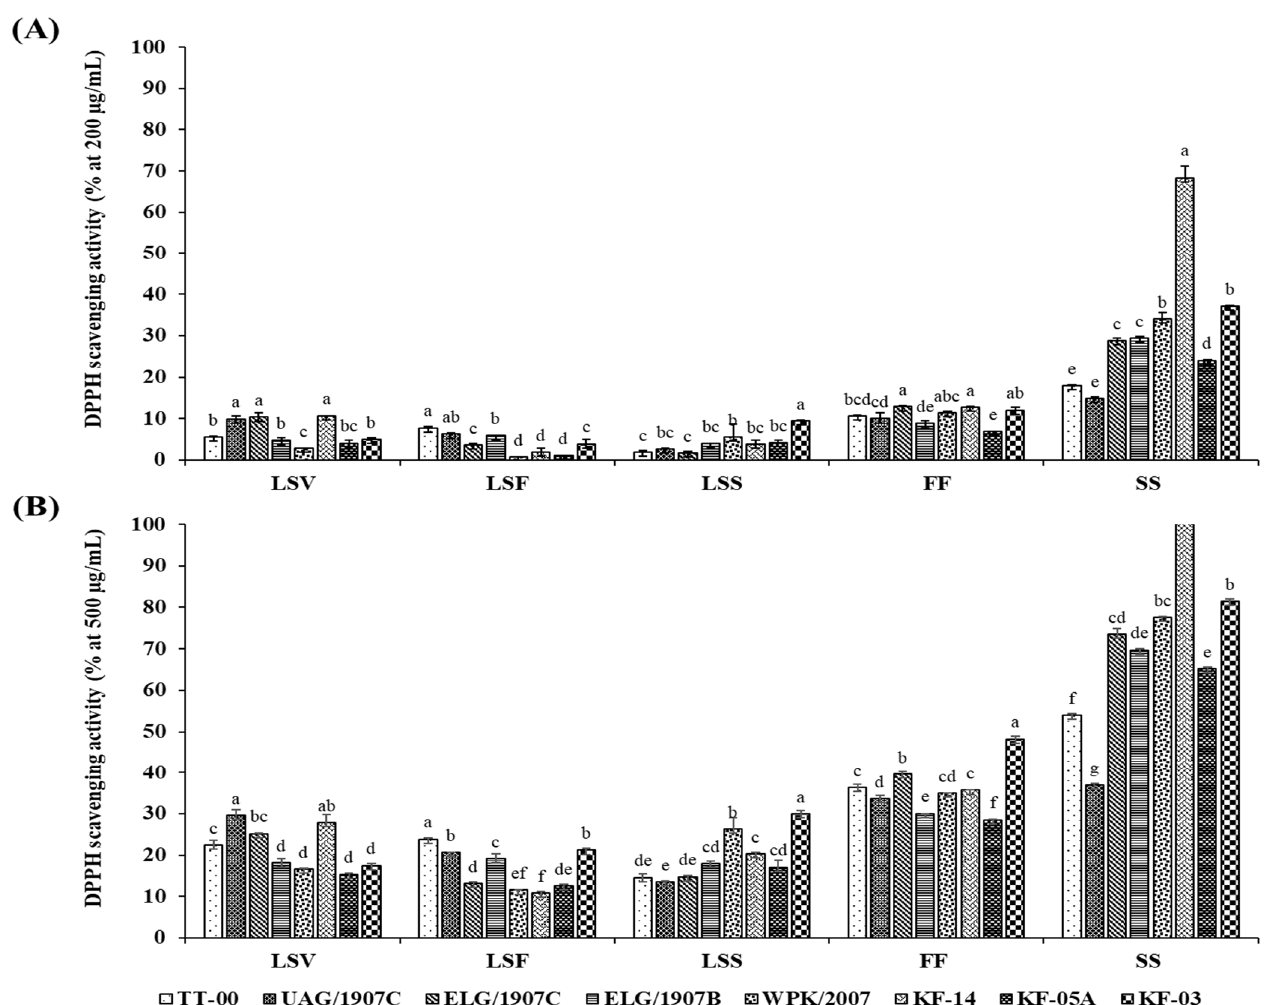
Figure 2. Dose-dependent ( A , B ) DPPH + radical scavenging activity of extracts from 8 accessions of CG organs collected at various stages. Columns with the different letters for each organ are significantly different ( p < 0.05). LSV = leaves and stem in the vegetative stage; LSF = leaves and stem in the flowering stage; LSS = leaves and stem in the seed set stage; FF = flower part in the flowering stage; SS = silique part in the seed set stage.